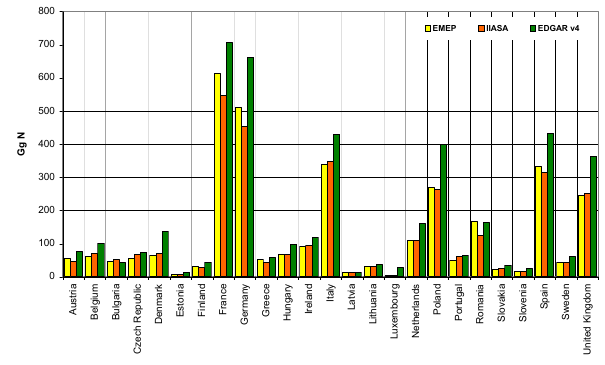
Fig. 1. Comparison of EU27 (not showing Malta and Cyprus) emissions of ammonia (expressed in Gg N) reported to EMEP and compiled by IIASA and the EDGAR v4 database for the year 2005. The slight differences between IIASA estimates and EMEP figures arise most likely from bilateral consultations with country experts, which led to corrections in agricultural emissions that had not (yet) been reflected in the EMEP inventories by recalculations of the year 2000 emissions submitted. Fig. 1 illustrates that differences between the EMEP dataset and data used for model emissions calculations with the GAINS model by IIASA (IIASA, 2009) are marginal for most countries. This was anticipated, as the EMEP emissions displayed represent official submissions by